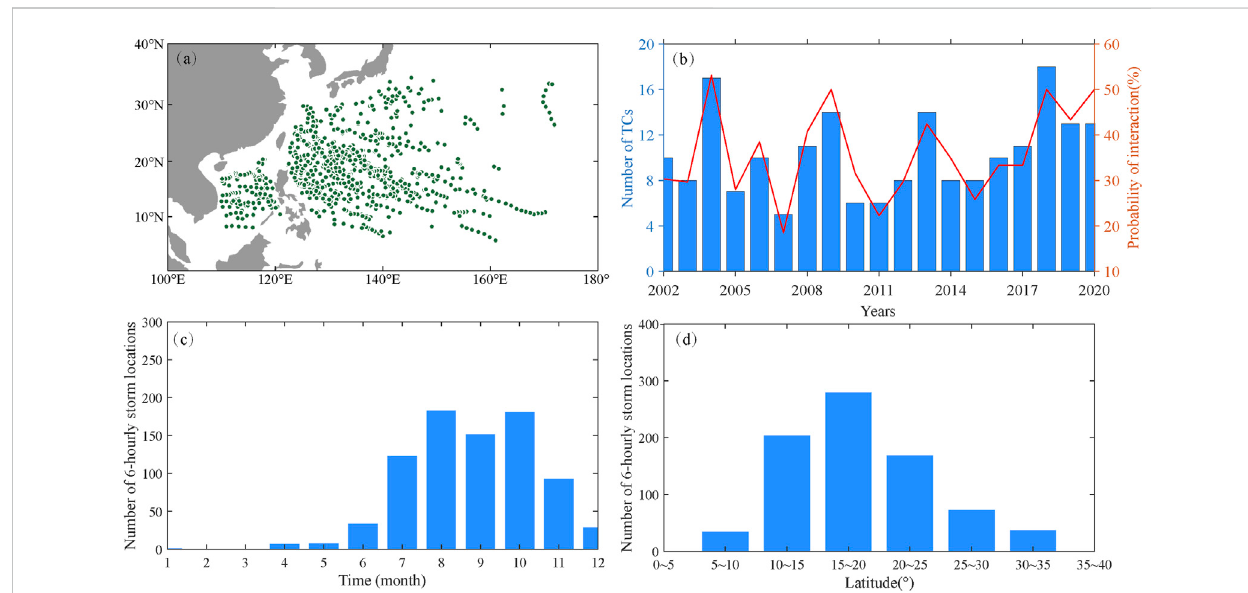
FIGURE 1 (A) Aspatialmapofthedistributionsforcycloneswhentheyencounteredcoldwakesfrom2002to2020. (B) Theinteractionprobabilityforcyclones when they encountered cold wakes and the number of cyclones for each year. (C) The number of 6-hourly cyclone track locations for each month. (D) The number of 6-hourly cyclone track locations for each